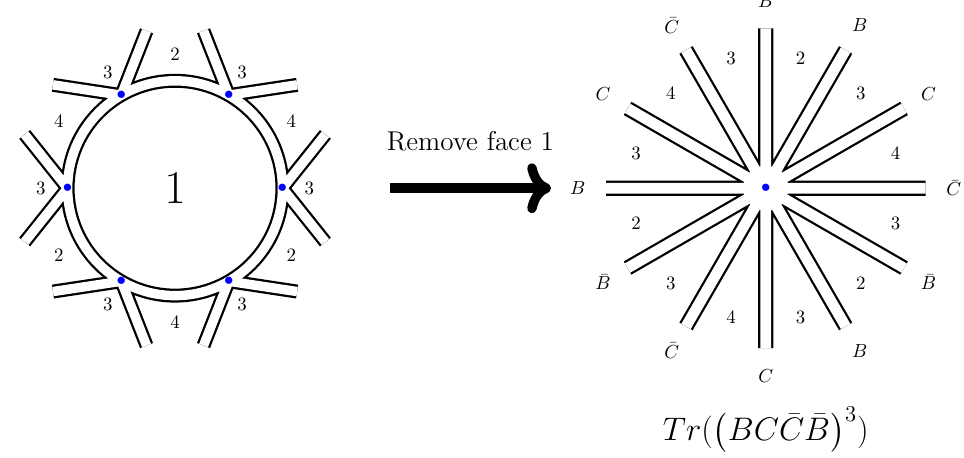
Figure 20 . Genus-two example: The unique way of organizing the four-valent vertices around a reference face 1, which leads to a single e(cid:11)ective vertex, once we remove the reference